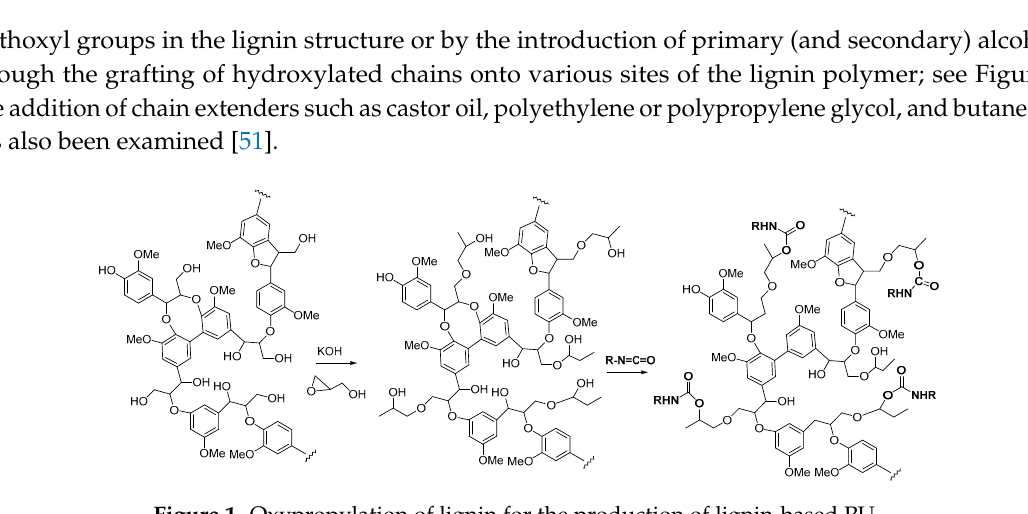
Figure 1. Oxypropylation of lignin for the production of lignin-based PU. Table 1. Information extracted from the literature on bio-based ones as a greener alternative. Vegetable oils are predominantly composed of triglycerides with three